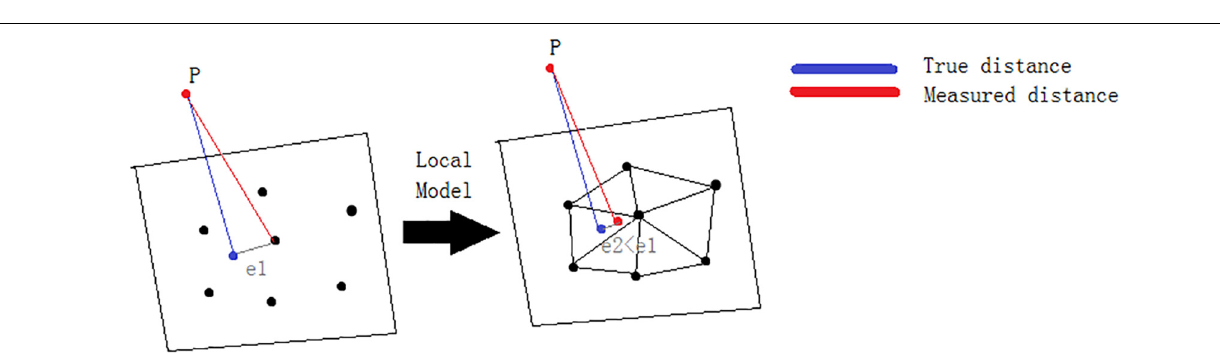
FIGURE 6 | A local model is used to calculate the distance between two point